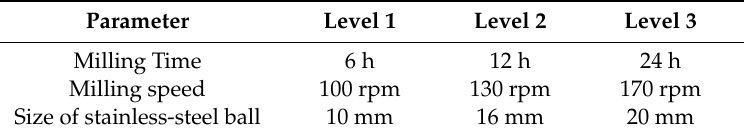
Table 1. Parameters selected and levels for each parameter.